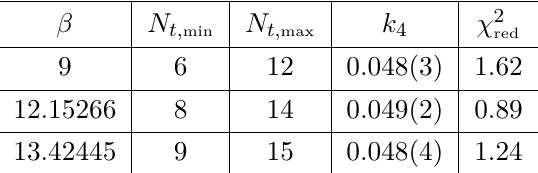
Table 11 . Results of the fits of our numerical data to eq. (6.7) using as input the values for σ 0 obtained from the